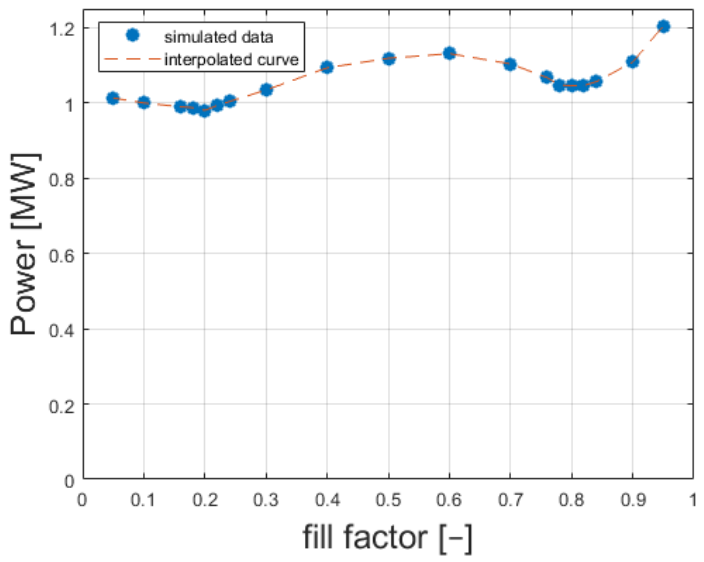
Figure 8. Instantaneous power required to overcome the braking forces. Power consumption as a function of fill factor and velocity.